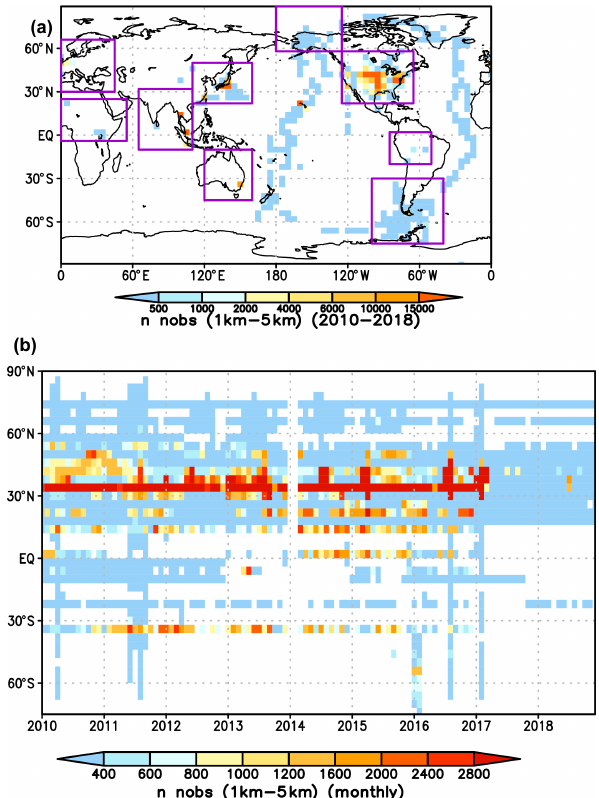
Figure 2. The spatial and temporal distributions of aircraft observa- tions used in evaluation of posterior NBE. (a) The total number of aircraft observations between 1–5km between 2010–2018 at each 4 ◦ × 5 ◦ grid point. The rectangle boxes show the range of the nine sub-regions. (b) The total number of monthly aircraft observations at each longitude as a function of